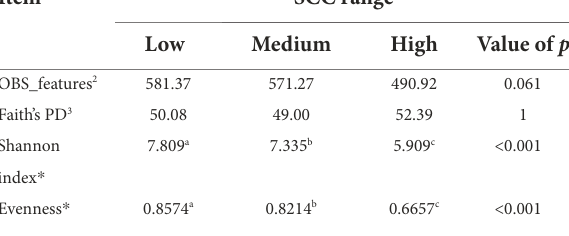
a–c Superscripts indicate difference ( p ≤ 0.05) using Bonferroni’s pairwise comparisons. 1 Low: SCC ≤ 200,000 cells/ml. Medium: 200,000 cells/ml < SCC < 800,000 cells/ml. High: SCC ≥ 800,000 cells/mL. 2 Observed features. 3 Faith’s Phylogenetic Diversity.